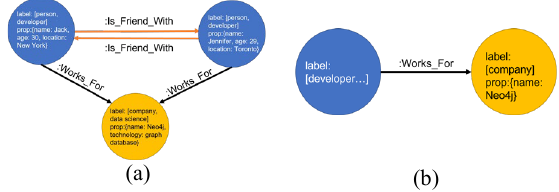
Figure 1. Example graph of Neo4j. (a)How a company and two developers that are friends to each other are connected. (b)Pattern defined within the